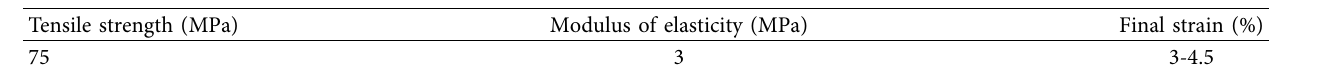
Table 4: Properties of epoxy resin [17].